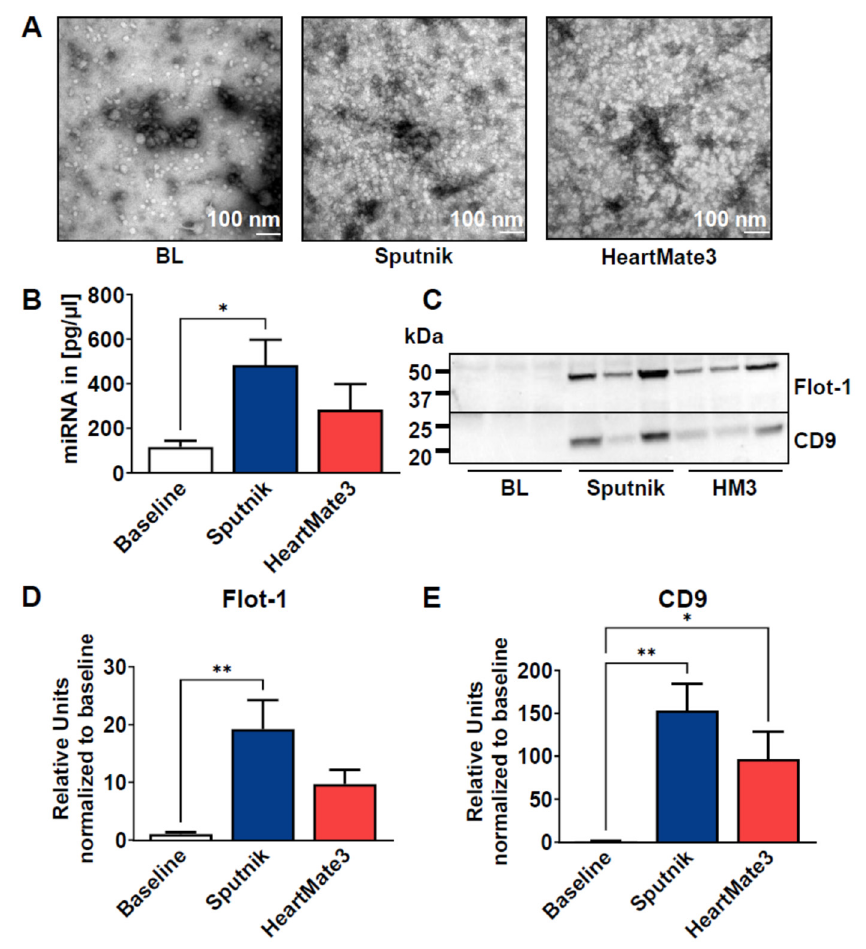
Figure 7. ( A ) Representative TEM images of EVs isolated by precipitation from the baseline in both Sputnik and HeartMate 3 test loops after 6 h. ( B ) MiRNA was isolated from EVs and quantified using a eukaryotic total RNA Pico chip. ( C ) Representative Western blot images of common EV markers in EVs isolated at baseline and after 6 h of circulation using the Sputnik and HeartMate 3 pumps. ( D , E ) Western blot bands were quantified and normalized to the corresponding total protein amount visualized in the acrylamide gels by stain-free technology and then compared to baseline. Data represent means ± SEM of six independent samples. Significance: * p < 0.05; ** p <